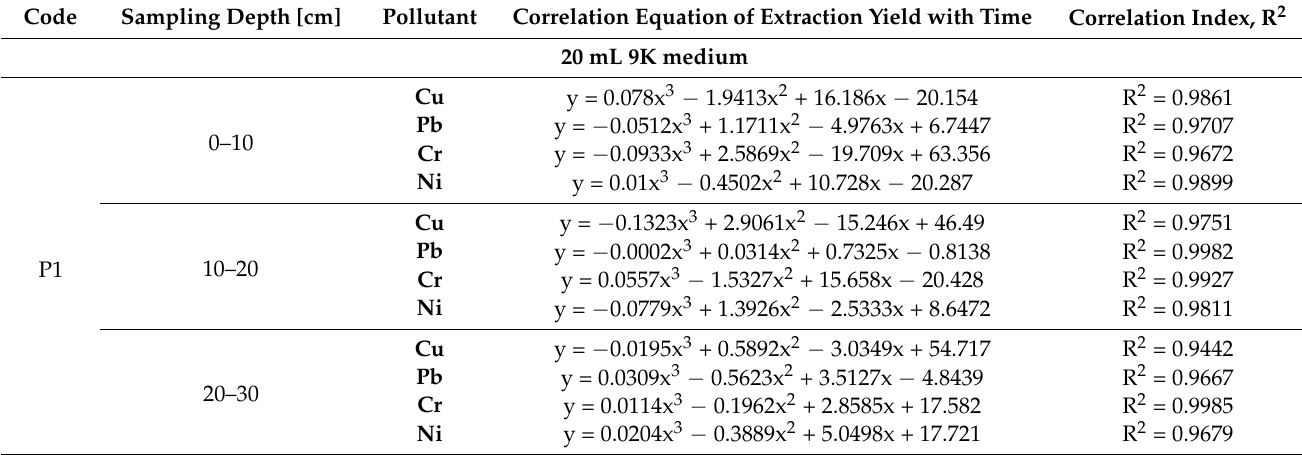
Table 4. Correlation equations of extractive process yield with time and correlation factor R 2